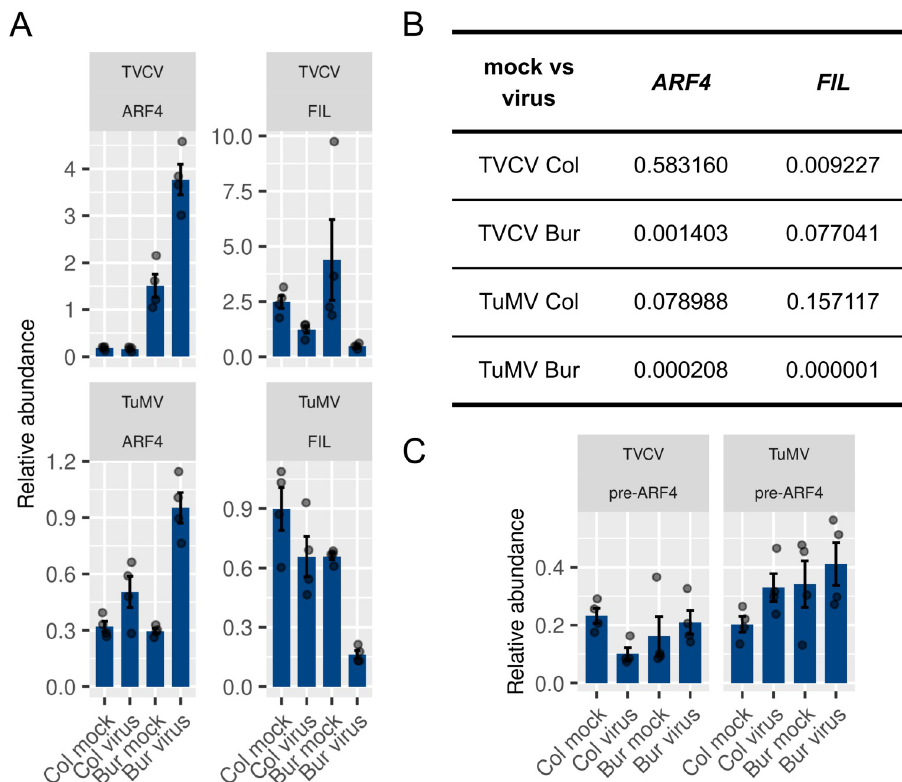
Fig 11. Validation of the ARF4 and FIL expression patterns with RT-qPCR. (A) RT-qPCRs were performed on the samples used for the high-throughput sequencing. Four biological and two technical replicates were measured per sample. The values for every biological replicate were calculated as the mean of the two technical replicates and shown as dots in the figure. The error bars represent the standard error of the mean of four biological replicates. The PDF2 gene (AT1G13320) was used as an internal reference [76]. (B) Unpaired, two-tailed Student’s t -tests at 95% confidence intervals were performed to assess if there is a significant difference between the means of the mock and virus-infected samples in the Col and Bur plants either in the TVCV or TuMV series. The resulting P -values for every pair tested are indicated in the table. Values less than 0.05 indicate a significant difference. (C) Expression pattern of the unspliced pre-mRNA transcript of ARF4 (genomic or gARF4 ) in the RNA-seq data. The error bars represent the standard error of the mean of four biological replicates. The individual data points are also shown.